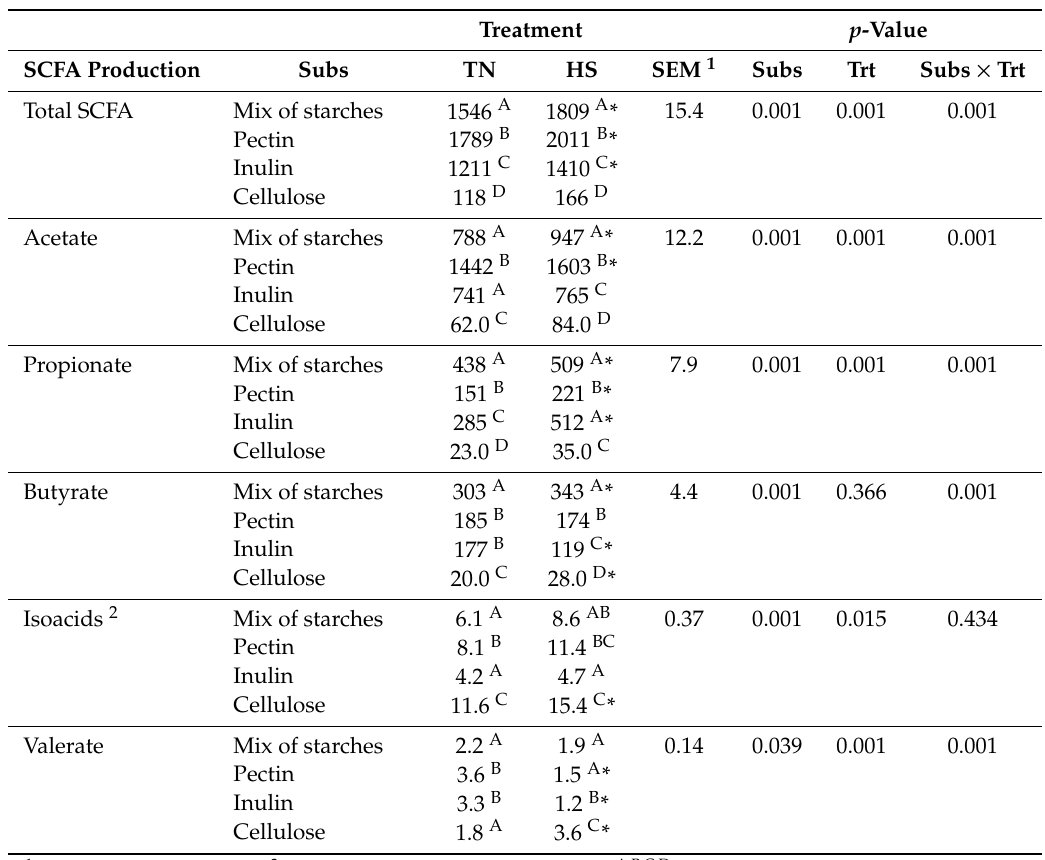
Table 2. Individual and total short-chain fatty acid (SCFA, µ mol) production after 24 h in vitro fermentation of four substrates (Subs) by fecal inocula obtained from pigs under thermoneutral (TN) or heat stress (HS) conditions.